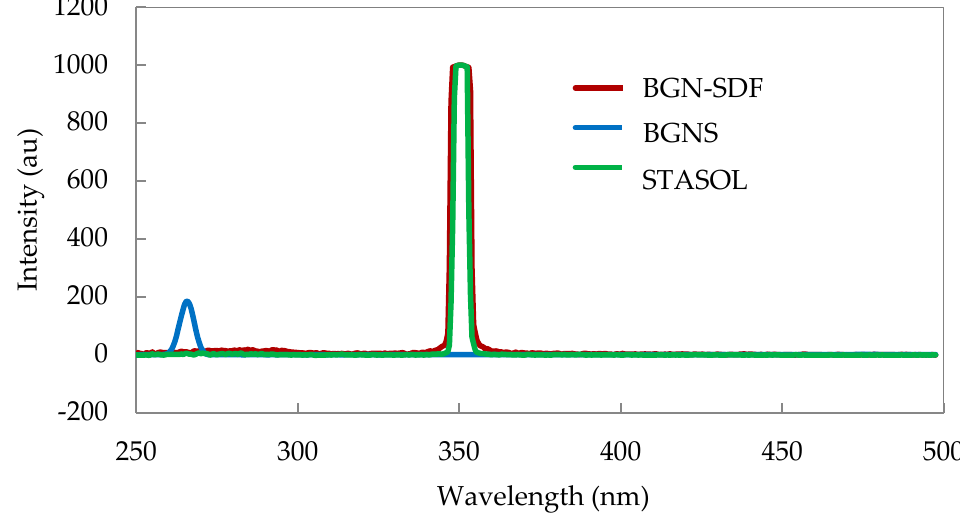
Figure 6. Fluorescence spectra of BGNS, BGN-SDF and STASOL. BGNS = Bambara groundnut starch; BGN-SDF = Bambara groundnut soluble dietary fibre; STASOL = Bambara groundnut starch- fibre